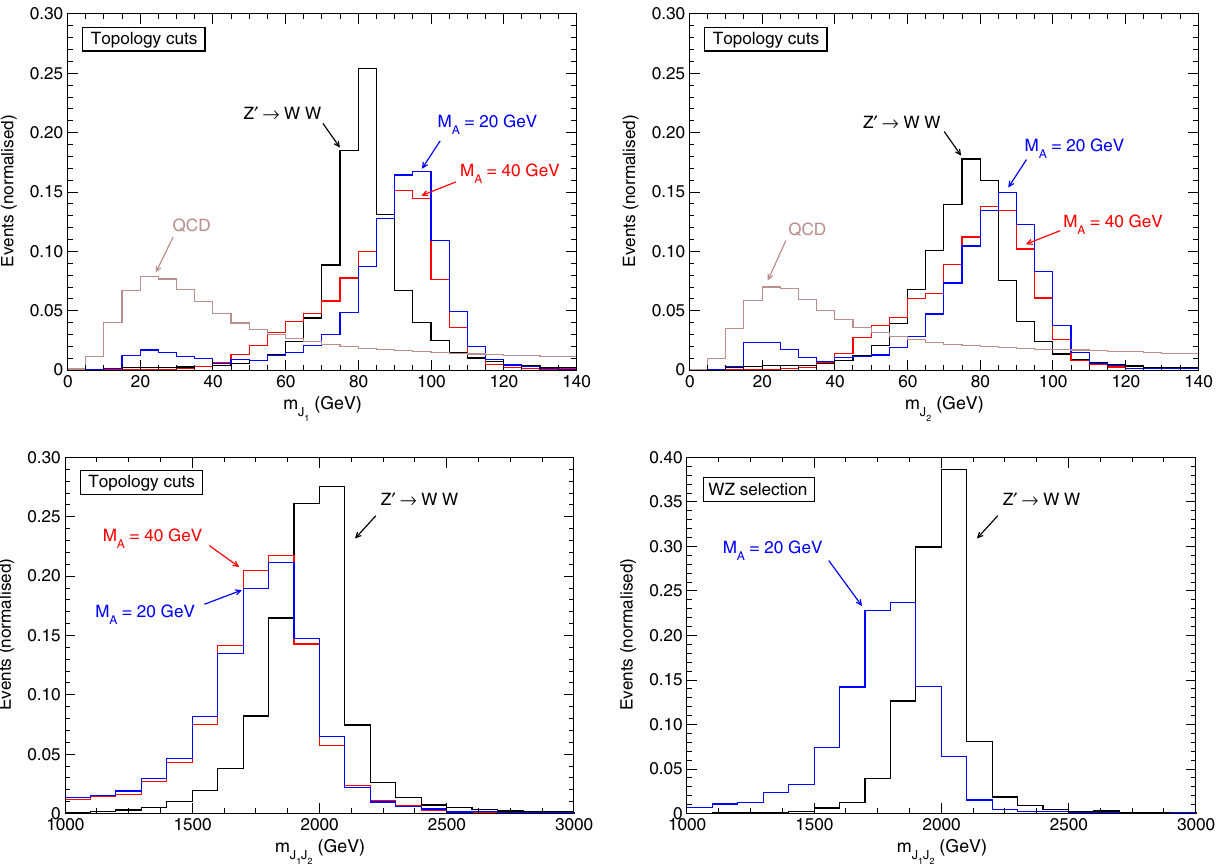
Fig. 7 Jet and dijet mass distributions for R → SS and Z (cid:8) → WW signals and the QCD dijet background for the ATLAS analysis